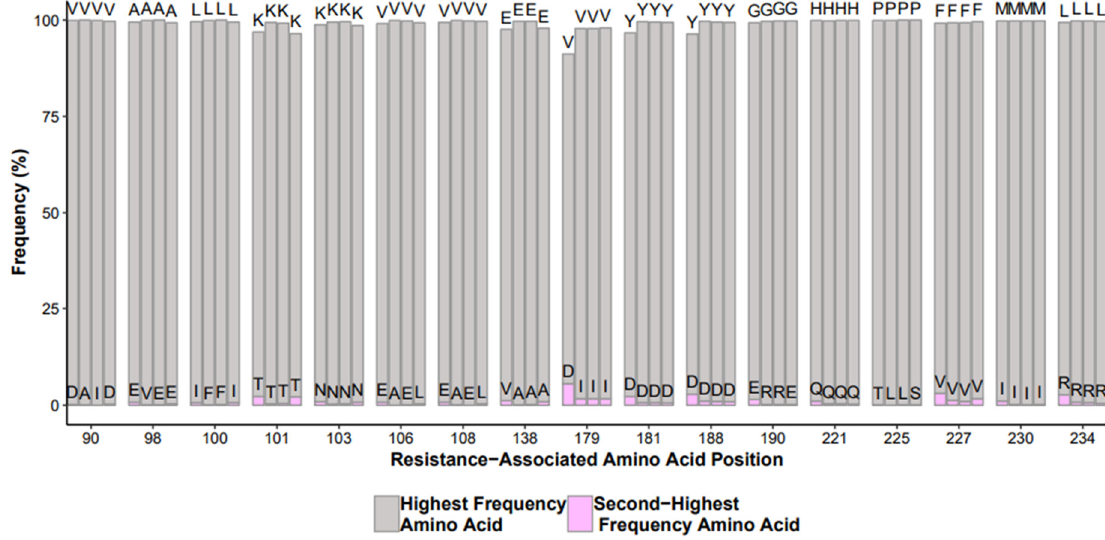
Figure 2. Example output of NNRTI mutations from control runs over time with highest frequency amino acid (gray) and variant (pink).